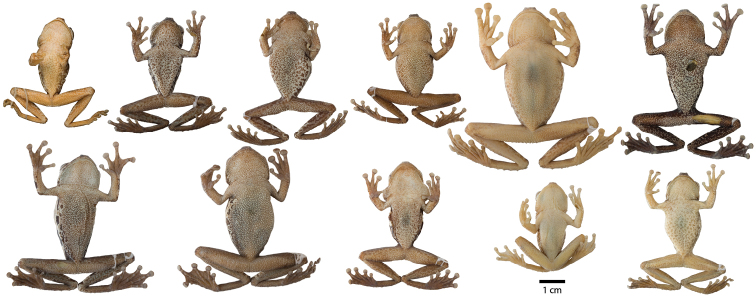
Variation in ventral coloration of preserved specimens of adult Osteocephalus buckleyi. Specimen identity and arrangement is the same as in Figure 3. All specimens are shown at the same scale.